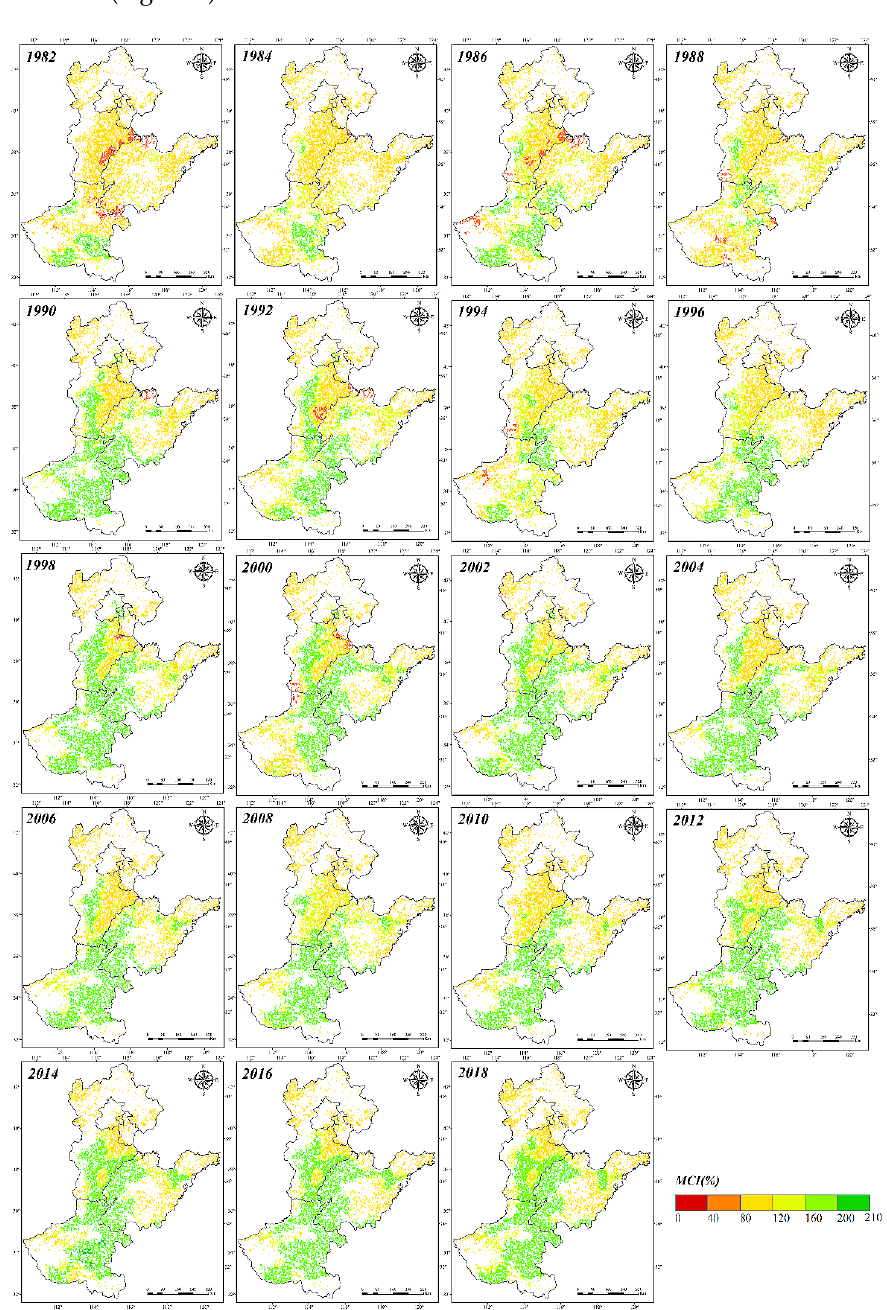
Figure 7. Spatial distribution of MCI of cultivated land on the NCP from 1982 to 2018.